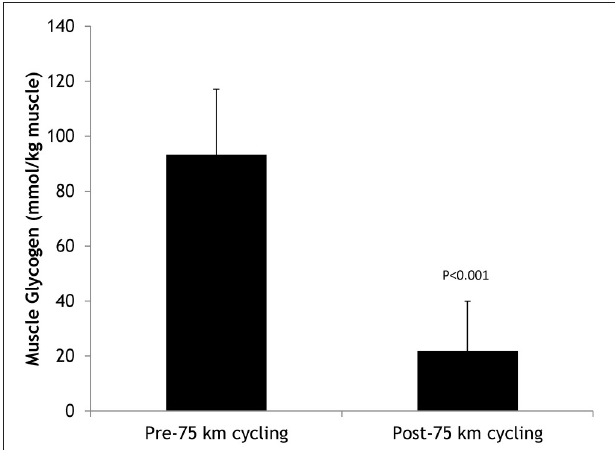
TABLE 3 | Cortisol, myoglobin, lactate, and glucose concentrations from blood samples in N = 20 male cyclists (mean ± SD ). Variable